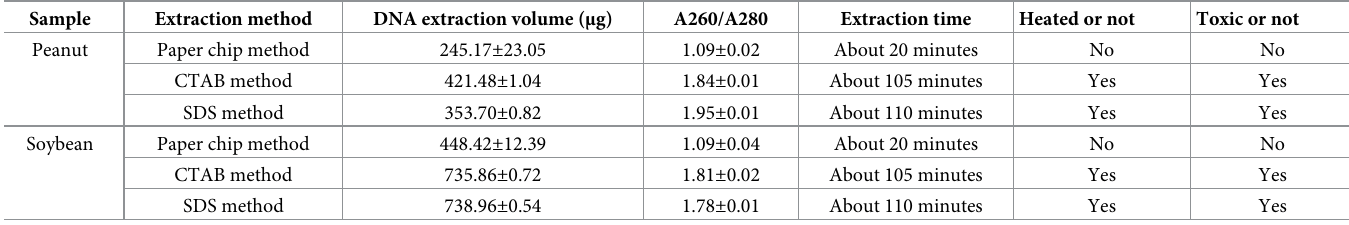
Table 1. Comparison of paper chip nucleic acid extraction method and other methods. Sample